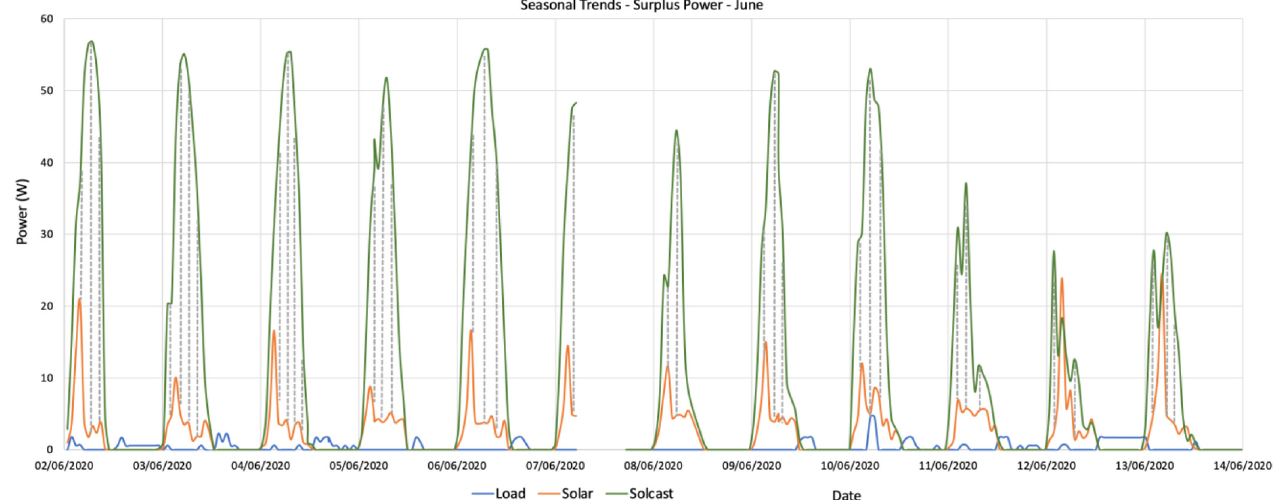
Fig. 6. Comparison of Solar power and Load Consumption for Urban SHS for 12 days in June.